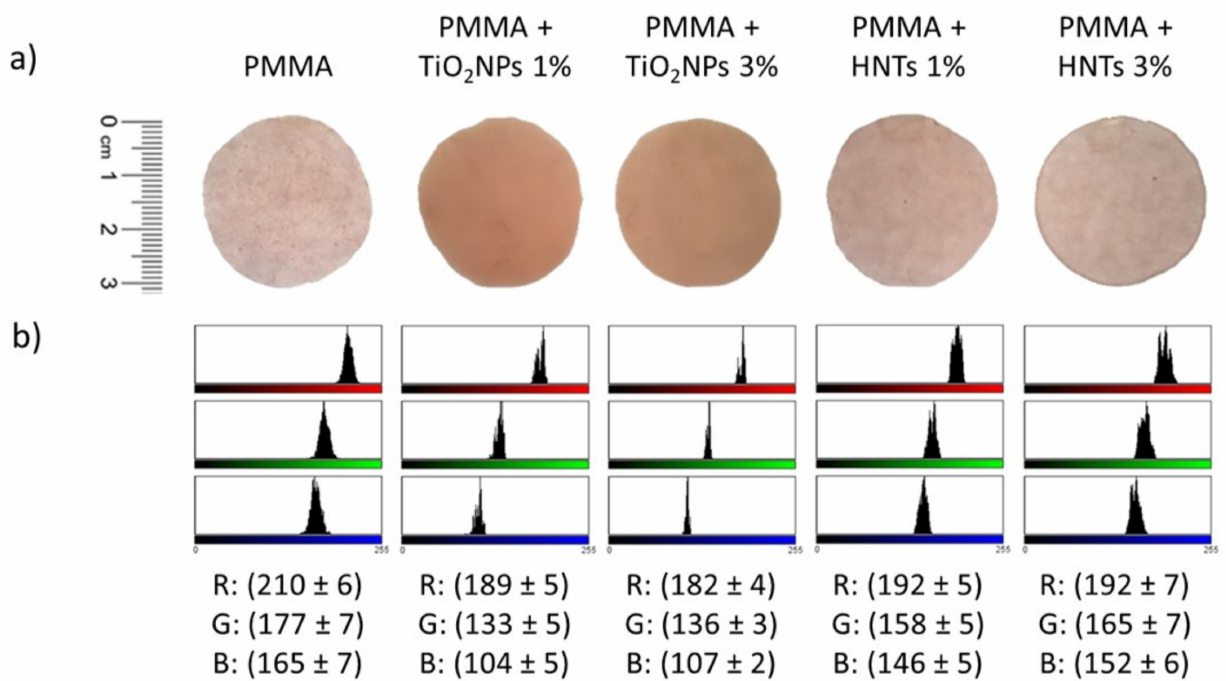
Figure 2. PMMA-based material samples images acquired with camera ( a ) and the corresponding RGB color analysis ( b